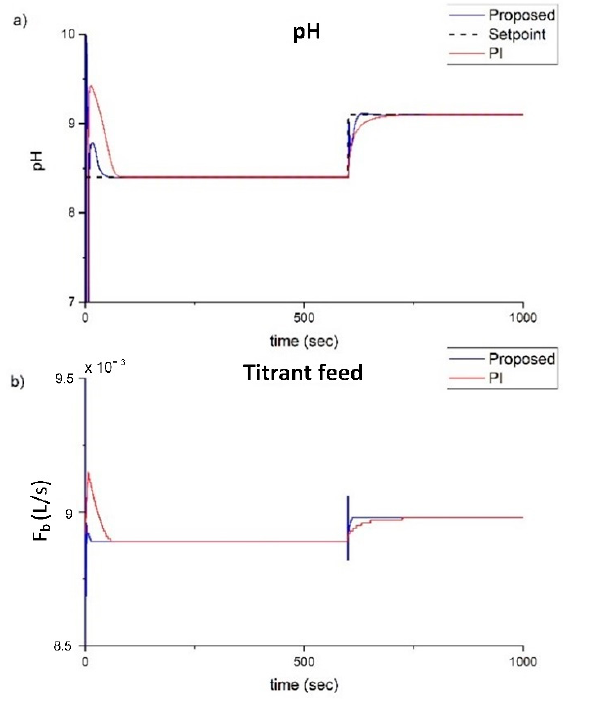
Figure 12. The output and input responses of pH controller in base range ( a ) pH and ( b ) titrant feed.